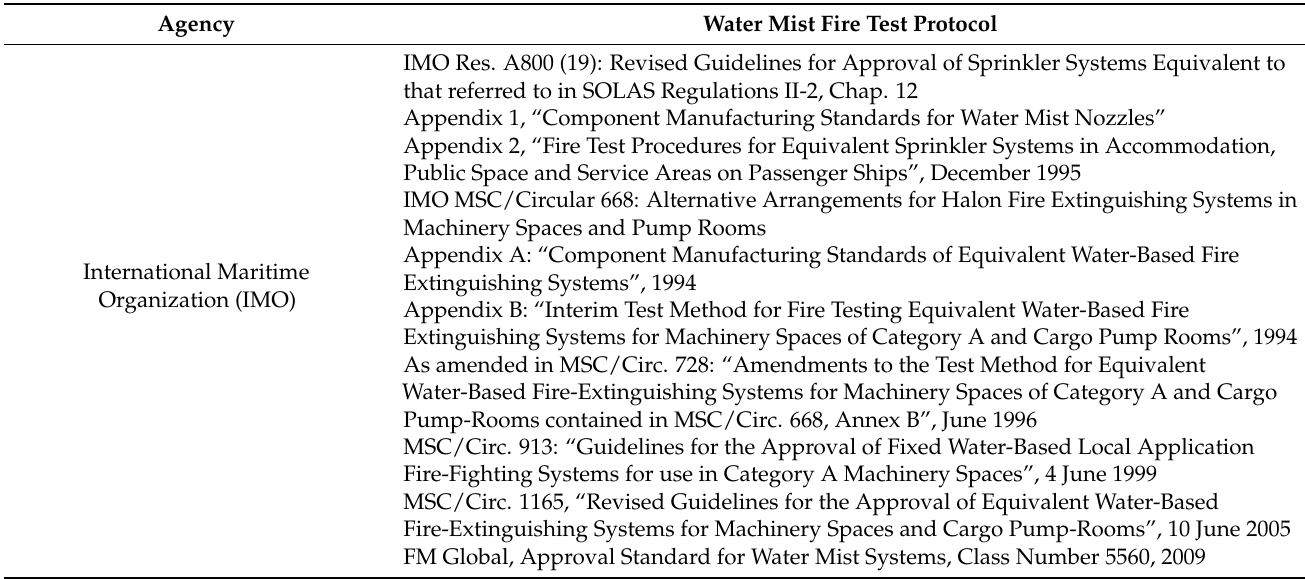
Table 5. Fire test protocol for water mist fire protection systems